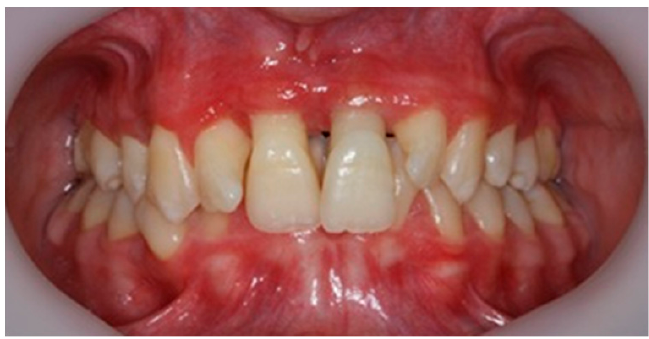
Figure 6. Clinical aspect after 3 months of periodontal therapy.